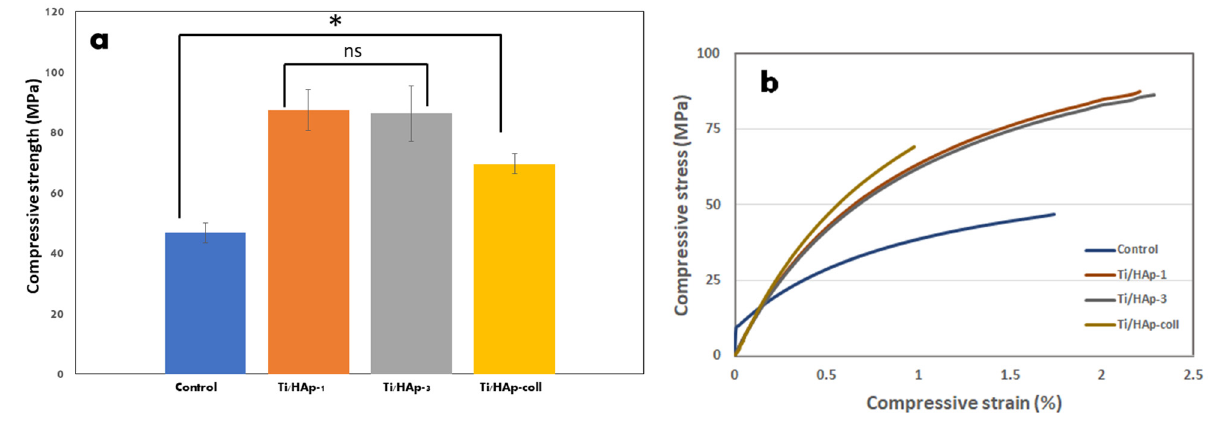
Figure 5. Compressive strength ( * : p < 0.05) ( a ) and stress-strain curve of coated substrates Ti ( b ). The compressive strength of Ti/HAp increased in reference to the uncoated Ti sub-